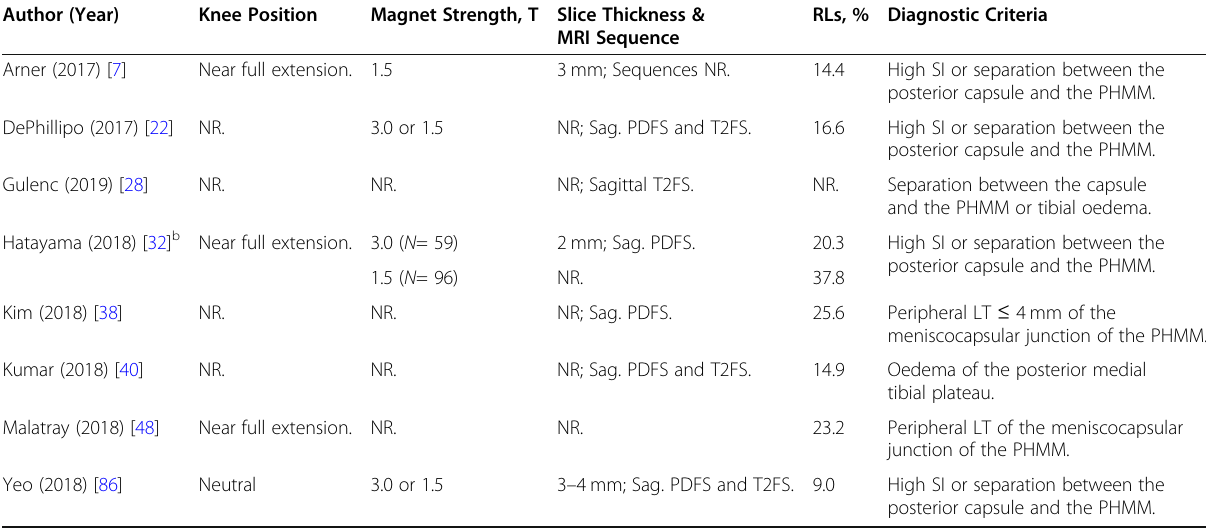
Table 2 MRI characteristics of the Studies included in this review a Author (Year)